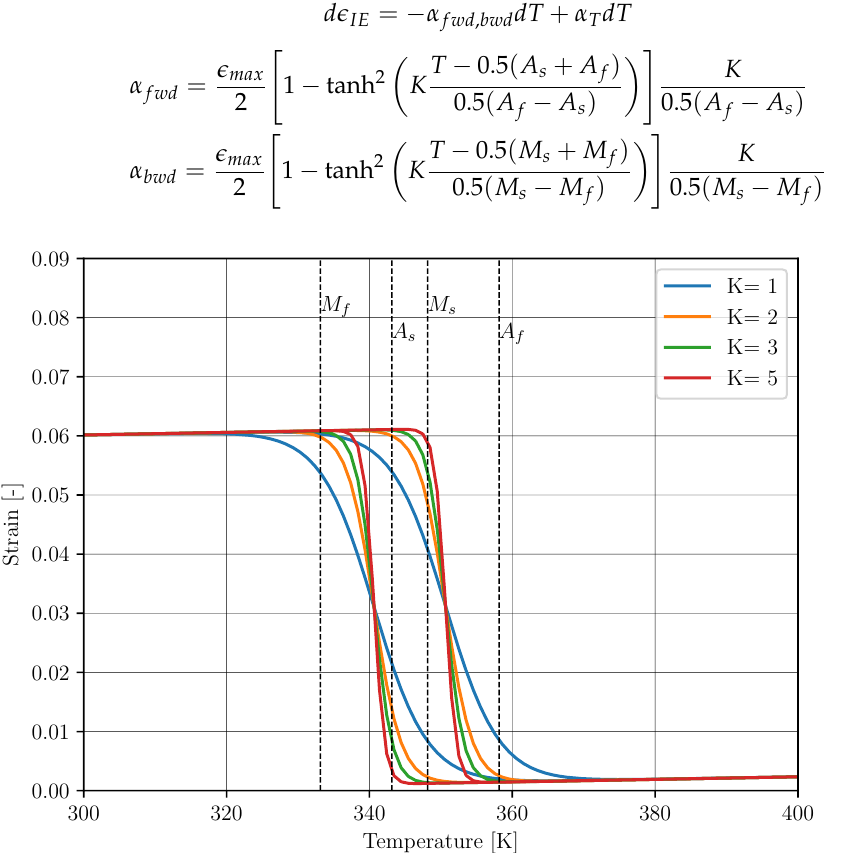
Figure 2. TWSME strain response as a function of temperature regarding different values of K